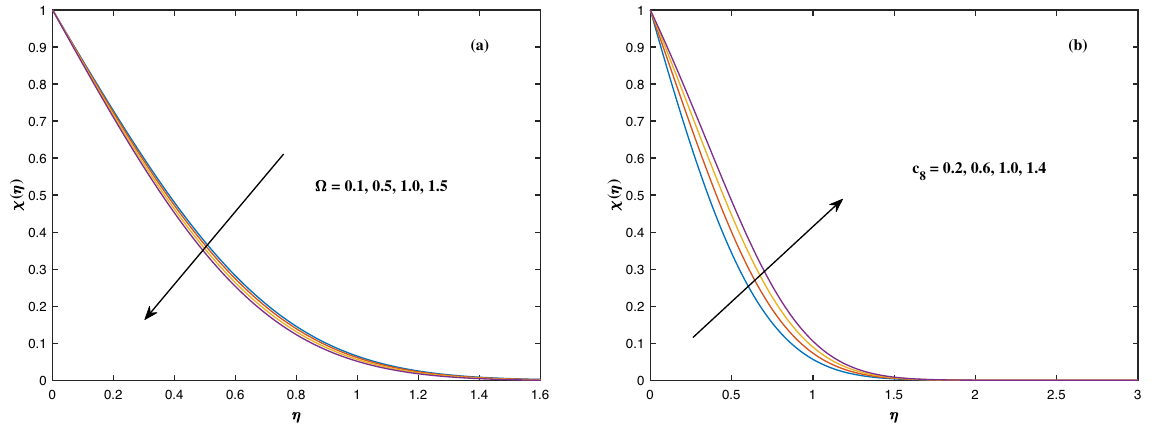
Figure 13. Fluctuation in χ(η) with ( a ) (cid:31) and ( b ) c 8 .